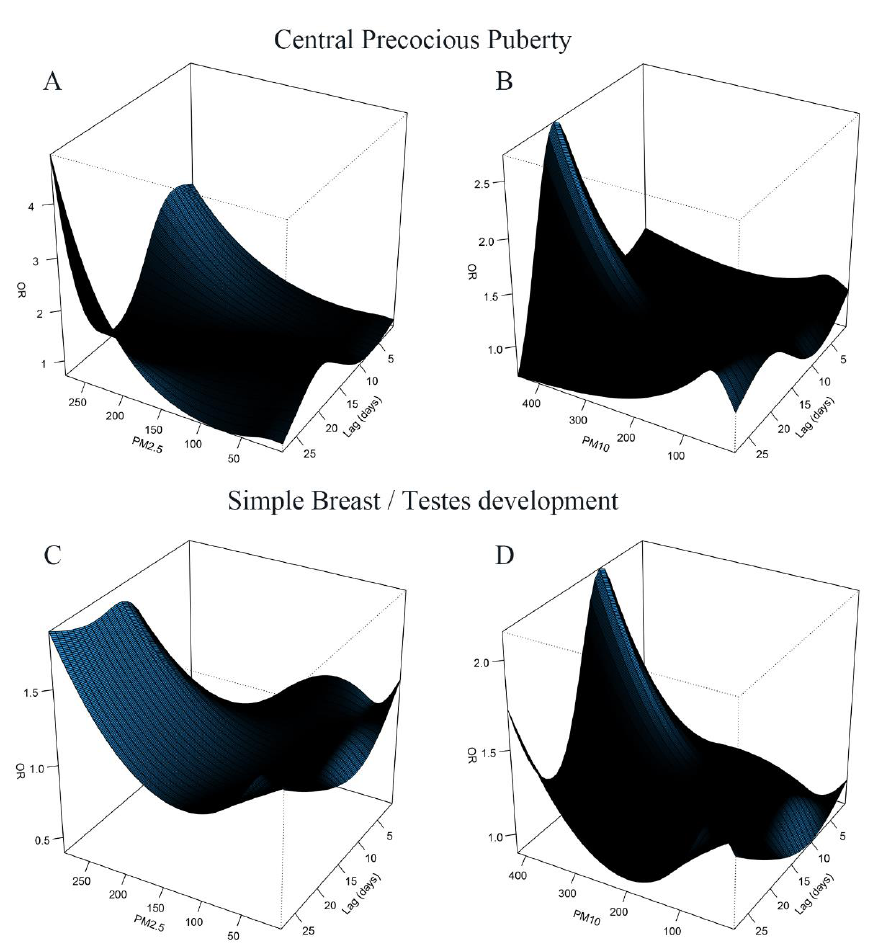
Figure 4. The three-dimensional (3D) plots of lag associations up to 28 days of PM 2.5 ( A , C ) and PM 10 ( B , D ) exposure with odds ratios (OR) of central precocious puberty and simple breast/testes